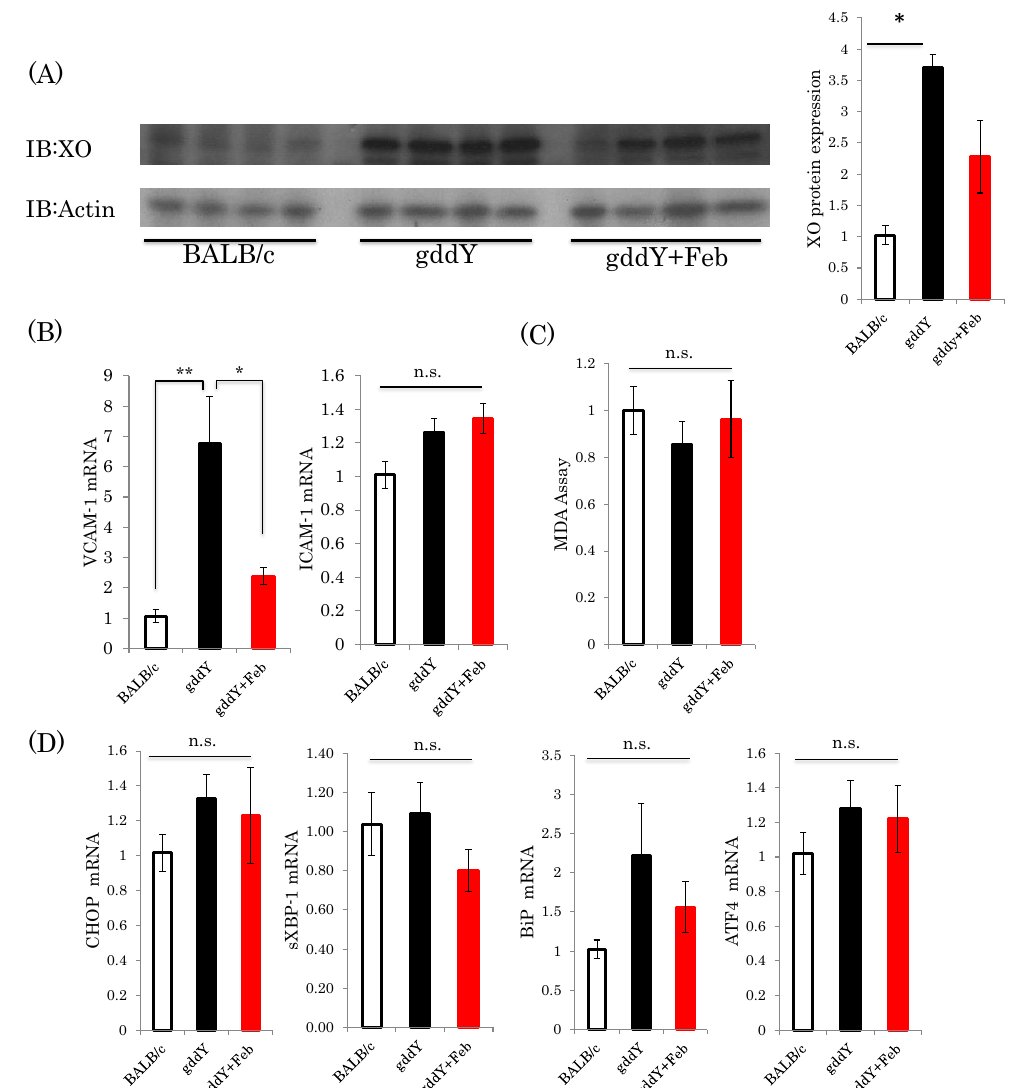
Figure 5. Febuxostat reduced the xanthine oxidase protein expression level but had no effects on oxidative or ER stress parameters. ( A ) XO and Actin protein expressions were examined by immunoblotting, and four representative blots from each group are shown (left panel); quantitation data are presented as a bar graph (right panel). (BALB/c control mice: n = 8, untreated gddY mice: n = 4, febuxostat treated gddY mice: n = 8); ( B ) Relative mRNA levels of VCAM-1 and ICAM-1 in the kidneys; ( C ) TBARS assay; ( D ) Relative mRNA levels of CHOP, sXBP1, BiP, and ATF4 in the kidneys. (BALB/c control mice: n = 8, untreated gddY mice: n = 4, febuxostat treated gddY mice: n = 8). *: p < 0.05, **: p < 0.01, n.s.: not